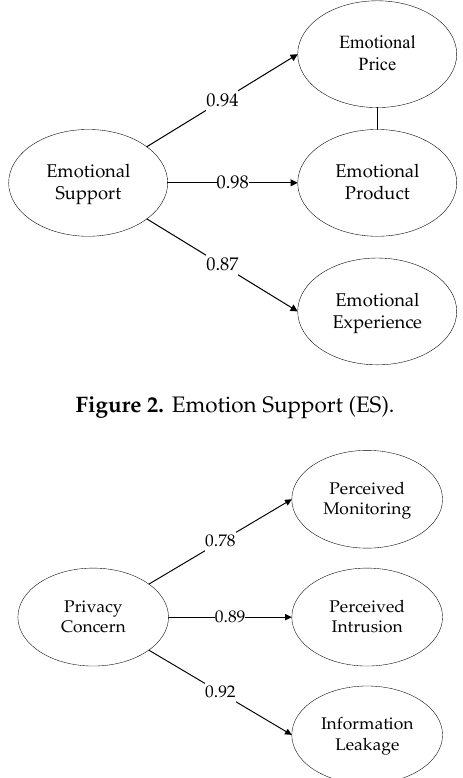
Figure 3. Privacy Concern (PC).